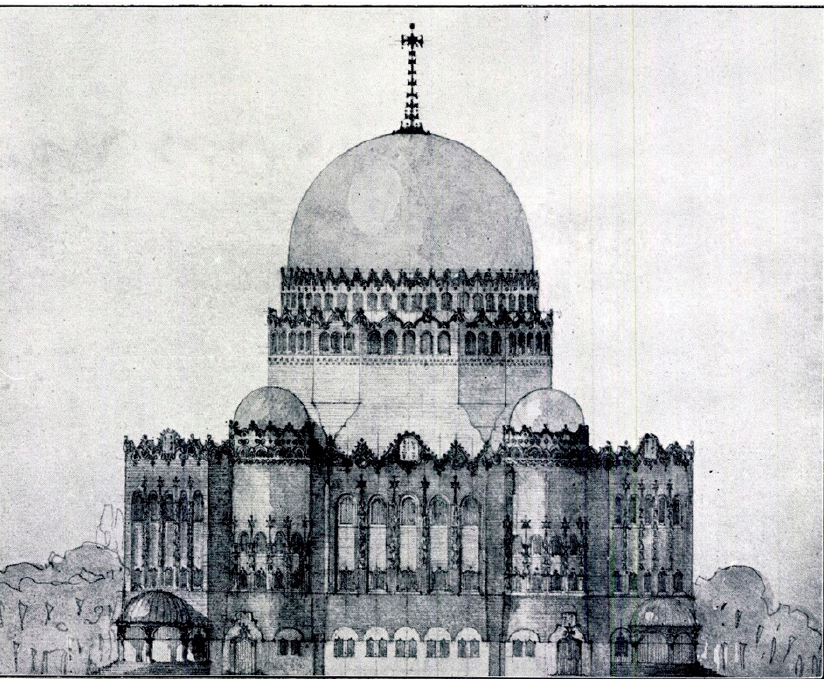
Figure 4. Hungarian Art Nouveau (Hungarian Secession) design for the Buda synagogue (Marcell Komor and Dezs ő Jakab, 1912). Source: Magyar E ́ pi ́ to ̋ mu ̋ ve ́ szet 1912, p. 23.